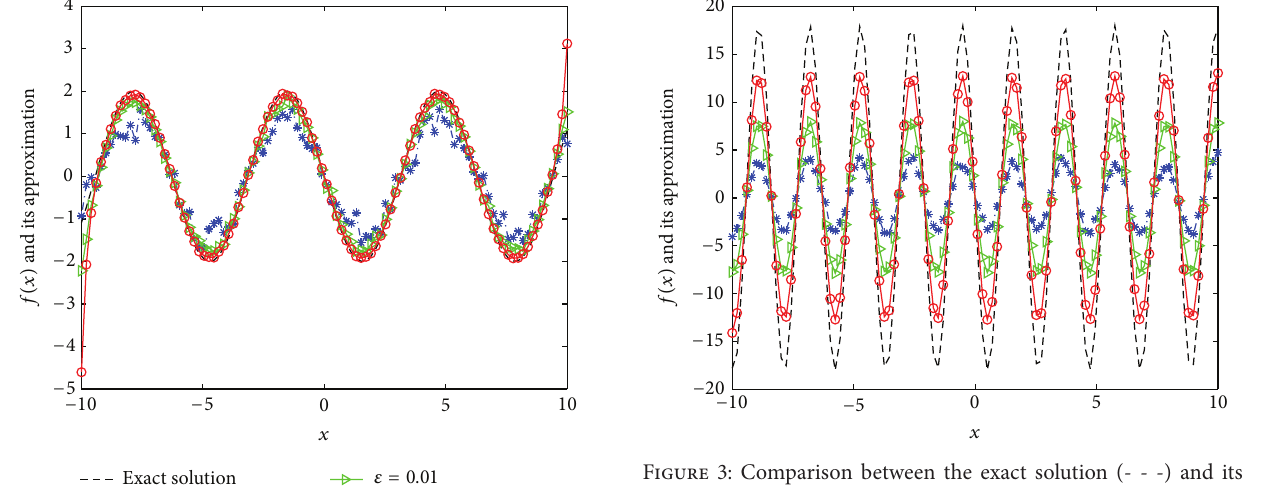
Figure 3: Comparison between the exact solution (- - -) and its computed approximations with 𝑘 = 3 and various noise levels of 𝜀 = 0.01 (−∗−) , 𝜀 = 0.001 (− ⊳ −) , 𝜀 = 0.0001 (− o −) for Example 5.